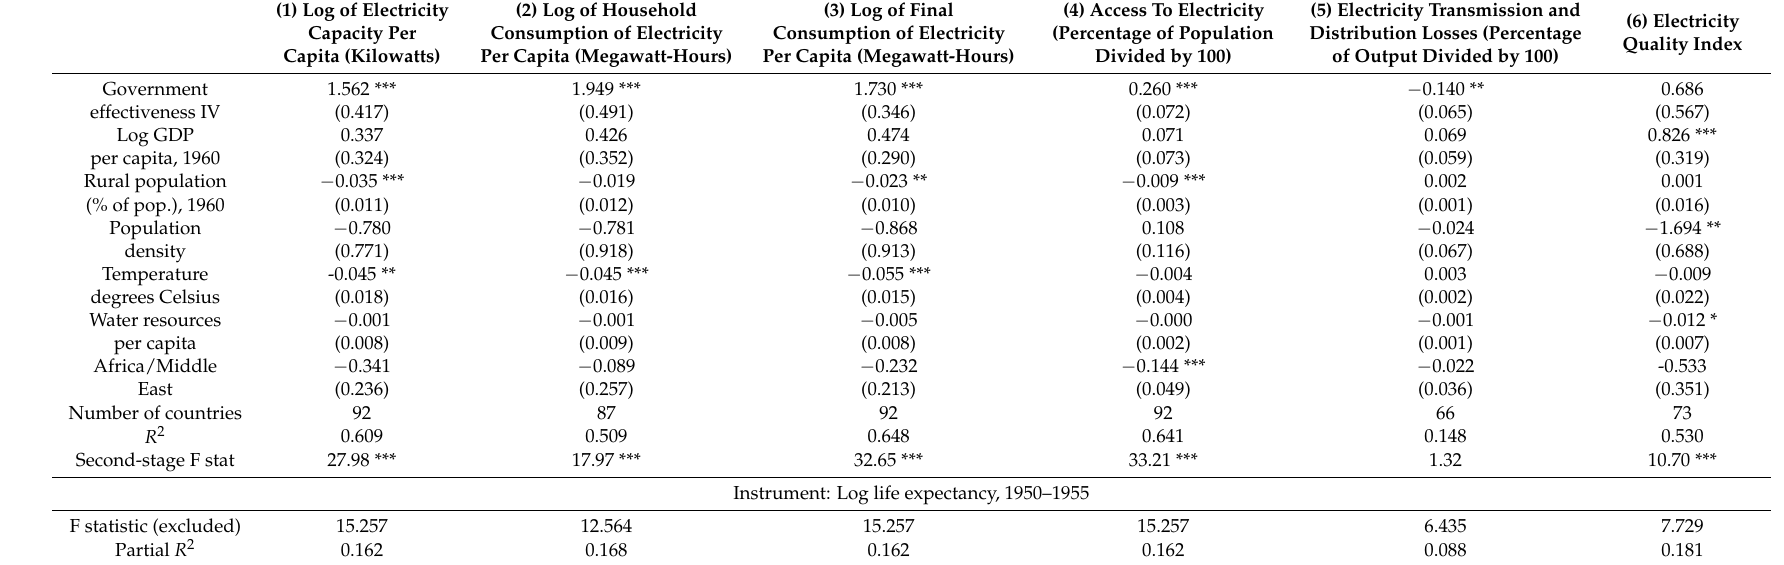
Table 4. Instrumental variable results, government effectiveness and electricity use,